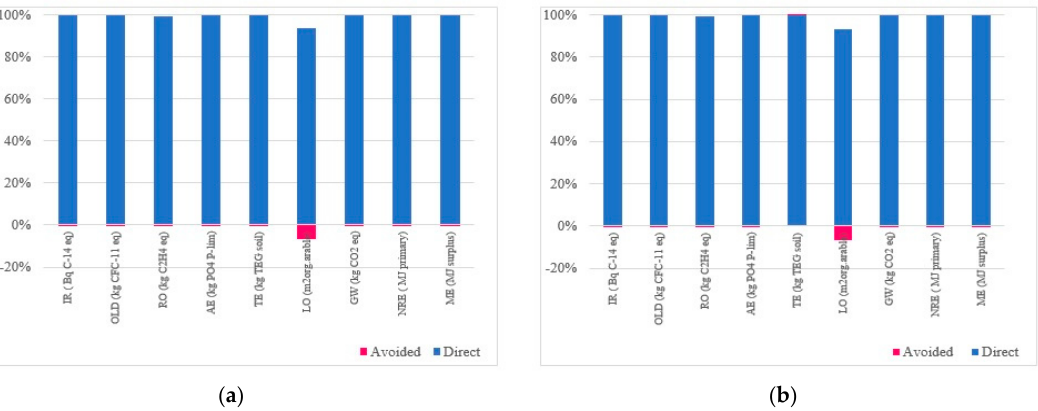
Figure 4. ( a ) Avoided burdens in scenario A; ( b ) avoided burdens in scenario B.